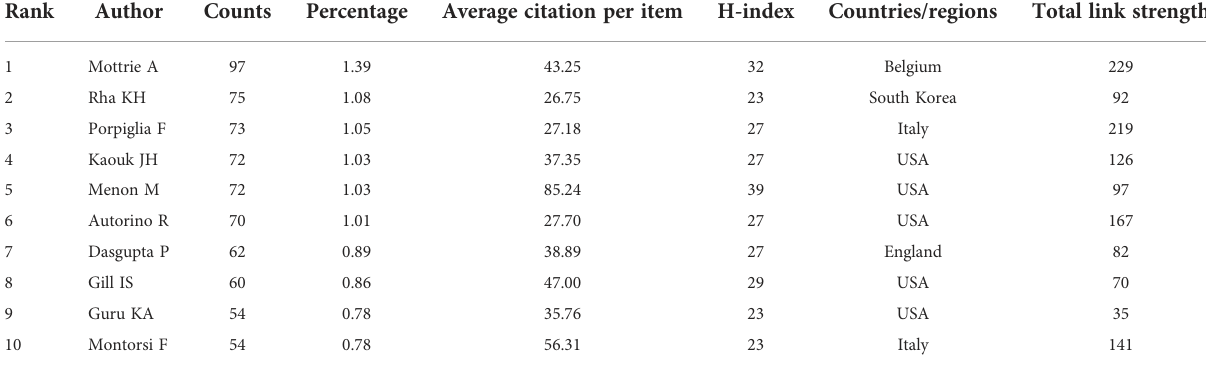
TABLE 5 The top 10 authors in number of publications related to robotic surgery in oncology.